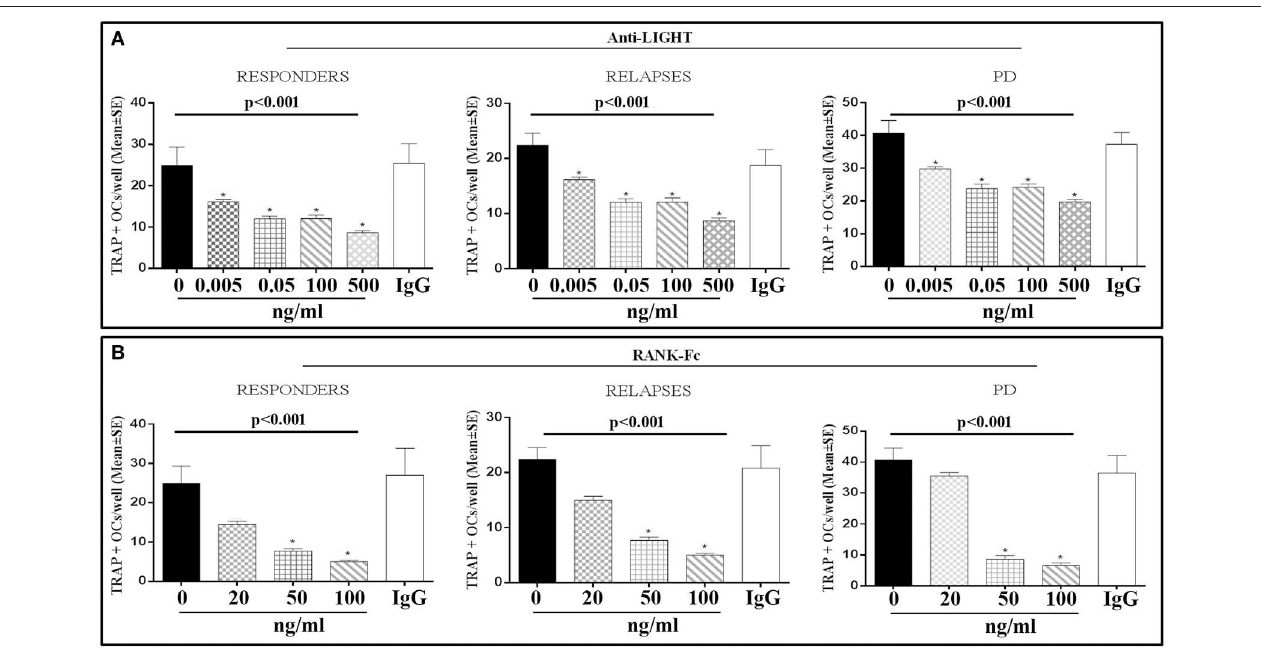
FIGURE 5 | Anti-LIGHT mAb and RANK-Fc inhibit the osteoclast formation in cultures from MM active bone disease responders, relapses, and in progressive disease patients. Multinucleated and TRAP + cells, differentiated from peripheral blood mononuclear cell (PBMC) cultures of responders, relapses and progressive disease (PD) patients with active bone disease (BD), were evaluated after 21 days of culture in the presence of anti-LIGHT mAb or RANK-Fc or control anti-IgG mAb. The treatment with anti-LIGHT mAb (A) or RANK-Fc (B) induced a dose-dependent inhibition of osteoclastogenesis, which was not affected by the control anti-IgG mAb. The number of multinucleated and TRAP + cells, identified as OCs, are represented in the graphs as mean ± SE of all experiments performed in quintuplicate. P < 0.001 for comparison of all groups (one-way ANOVA on ranks), * p < 0.05 vs. CTRL (with Tukey post-hoc test).